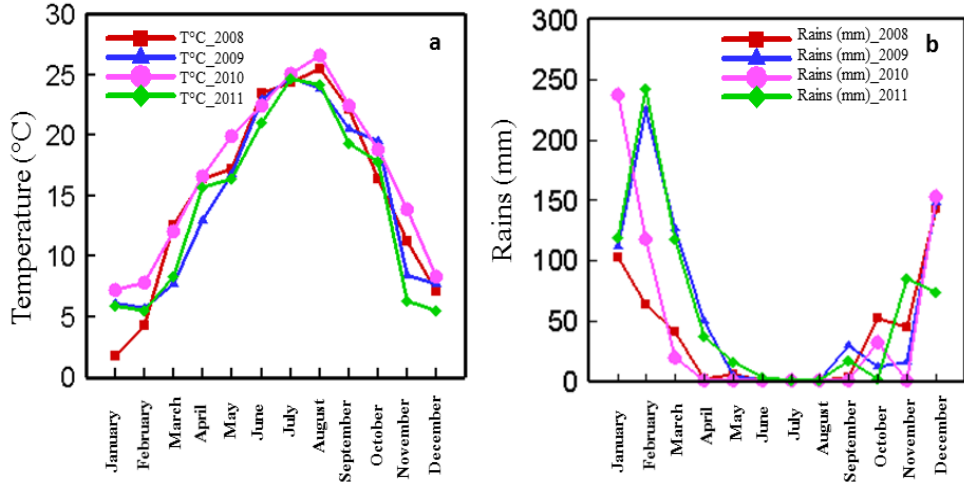
Figure 4. Temperature ( a ) and rainfall ( b ) as a function of time over four years (2008, 2009, 2010, and